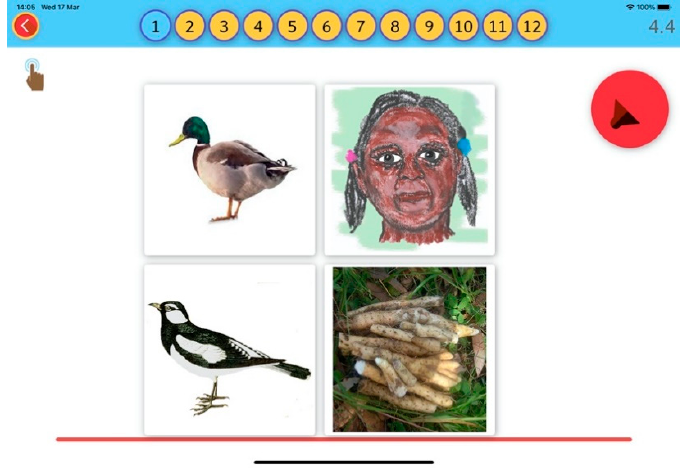
Figure 3. App with variety of picture sources.